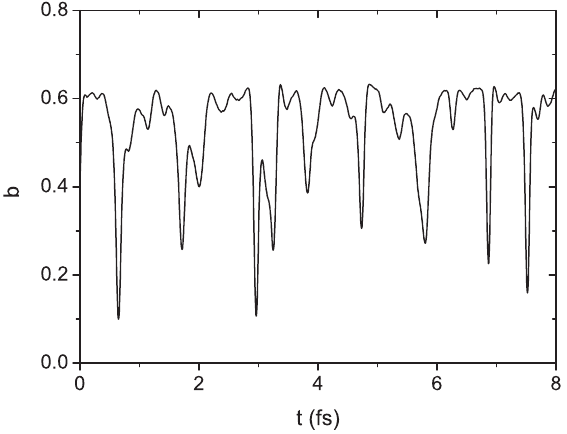
FIG. 5. Modulus of bunching factor versus time at the exit of the planar undulator SASE3 (position 55 m on Fig. 4). A central part of the electron bunch is